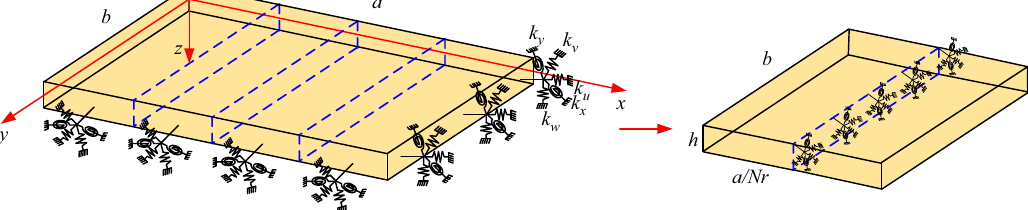
Figure 1: Calculation model of rectangular plate